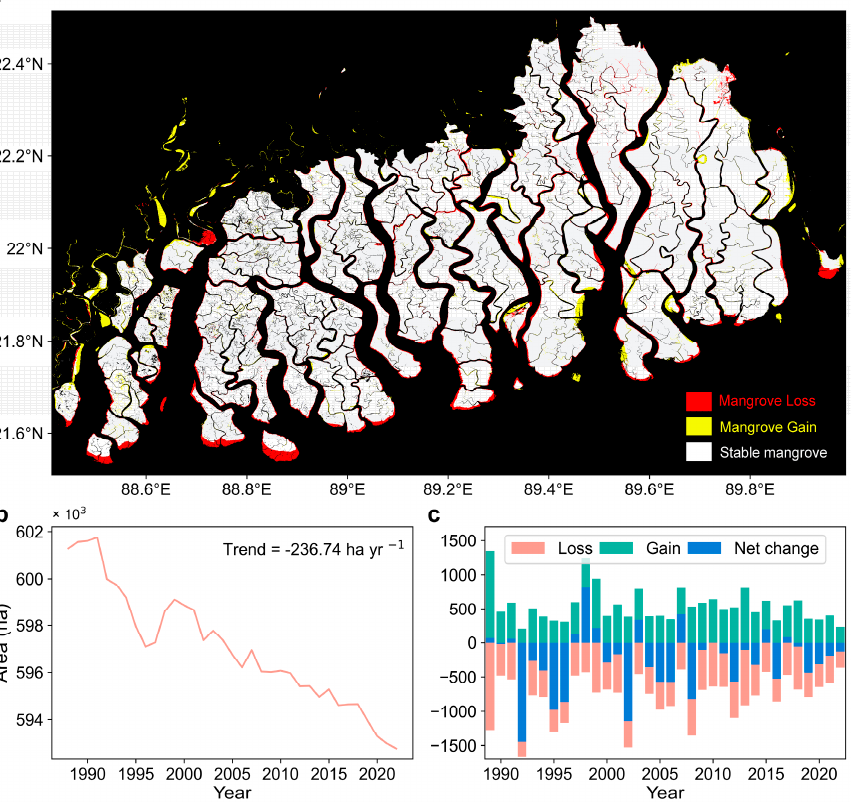
Figure 6. The pattern of the Sundarbans mangrove changes from 1988 to 2022. ( a ) The mangrove change map. ( b ) Change in total mangrove areas over time. The trend was determined using the Theil–Sen slope estimator. ( c ) Temporal change of areas in mangrove loss/gain and net change (gain minus loss).